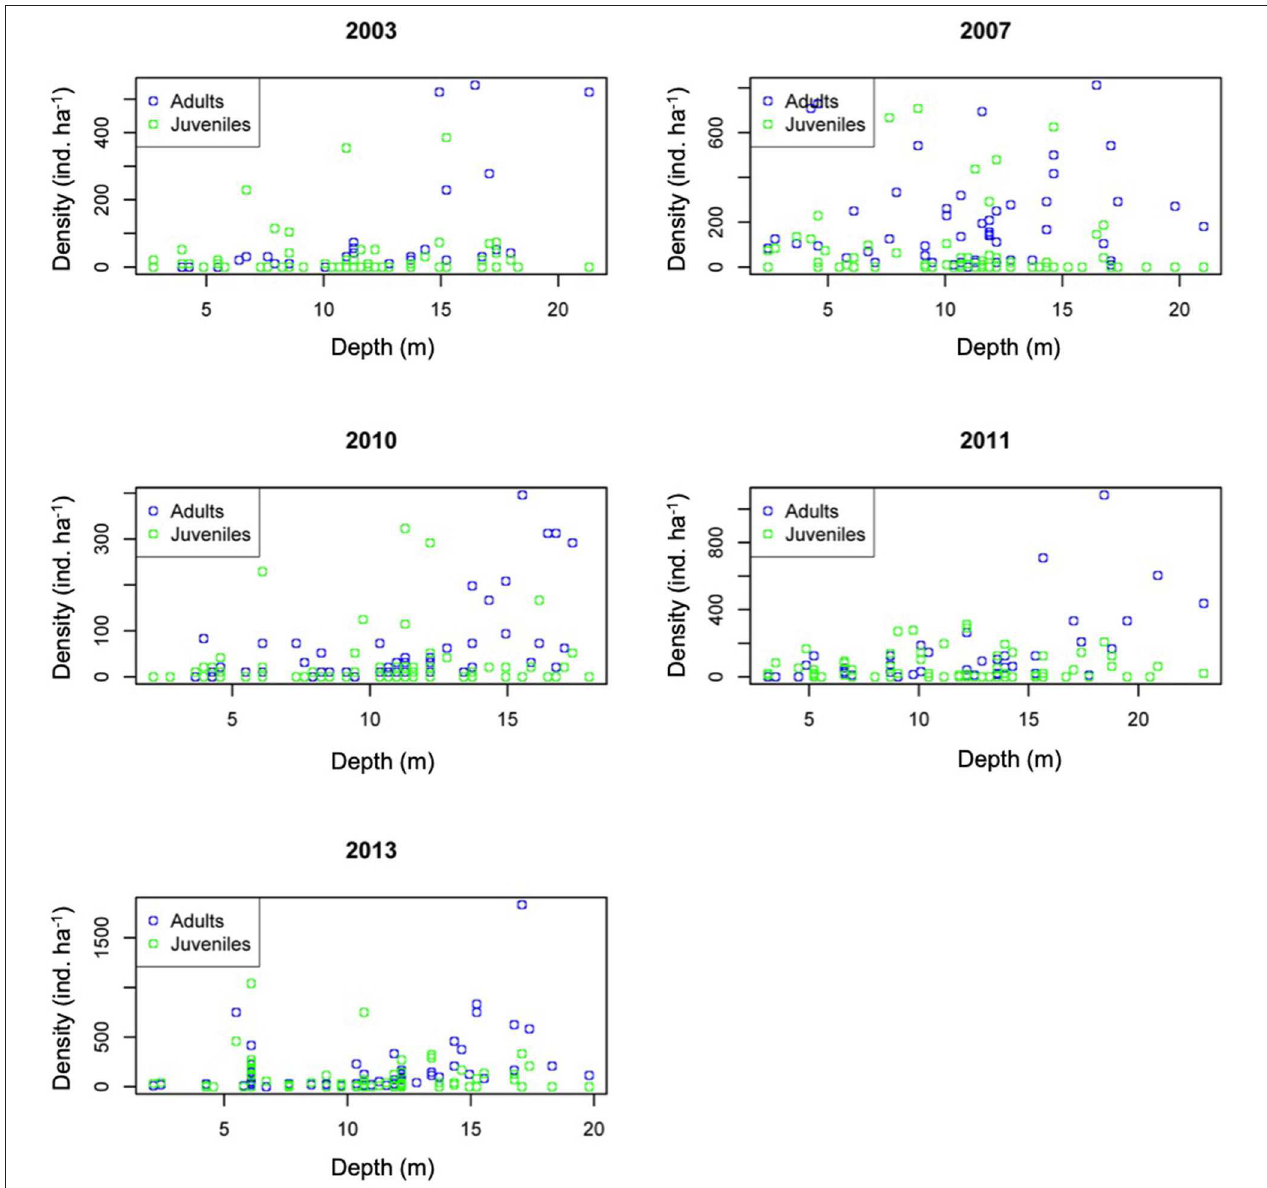
FIGURE 2 | Relationships between sampling depth and densities (ind. ha − 1 ) of A. gigas throughout the study period (2003–2013) in Serrana